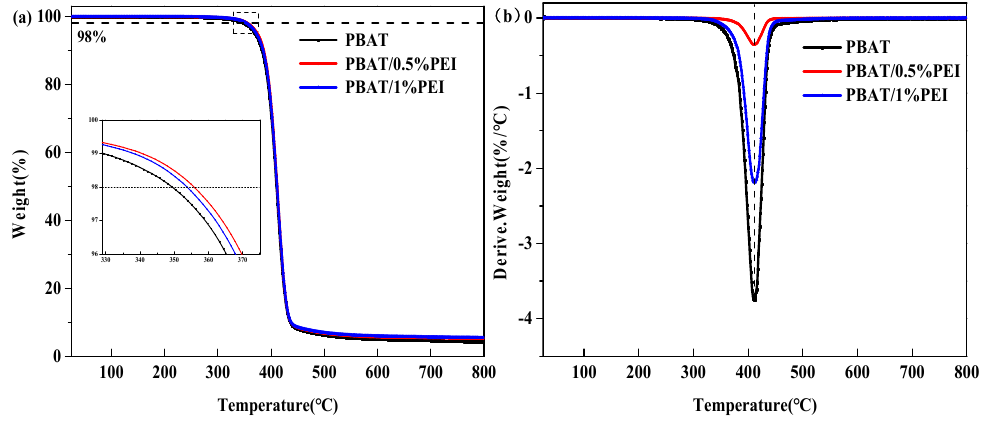
Figure 4. TG -( a ) and DTG- ( b ) curves for PBAT and PBAT/PEI films. Figure 4. TG—( a ) and DTG—( b ) curves for PBAT and PBAT/PEI films.